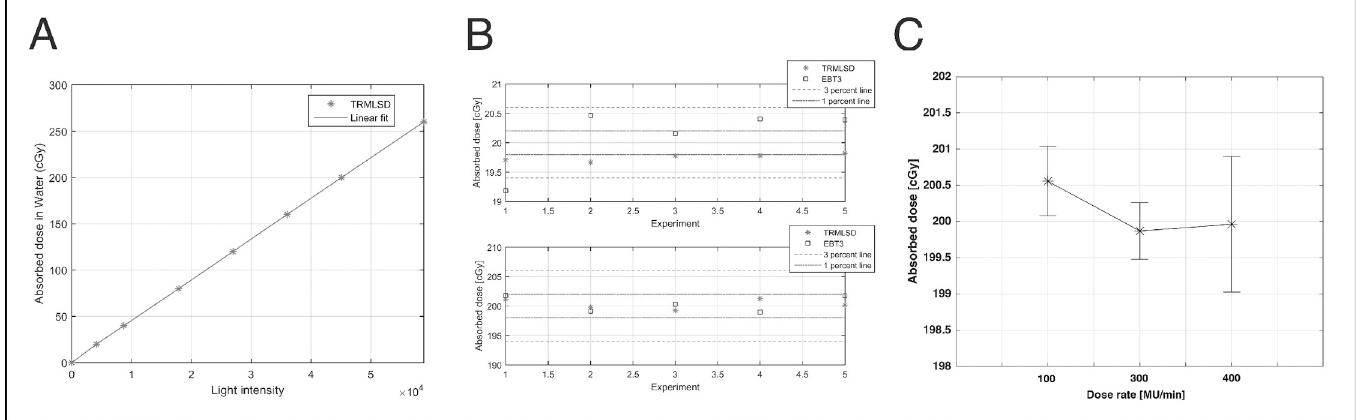
Fig 12. Test results for (A) does linearity, (B) reproducibility, and (C) dose rate dependency of TRMLSD. https://doi.org/10.1371/journal.pone.0246742.g012 5.0 cm of the ionization chamber data (85.2%) and are plotted in Fig 13. The relative errors with respect to the ionization chamber data were − 1.51%, 0.19%, and − 0.23% with the TRMLSD, and − 2.16%, − 0.80%, and − 1.99% with the EBT3 film at 2.0, 10.0, and 20.0 cm, respectively. The mean of the relative errors between the TRMLSD and EBT3 films was less than 0.64% and 1.65%, respectively.